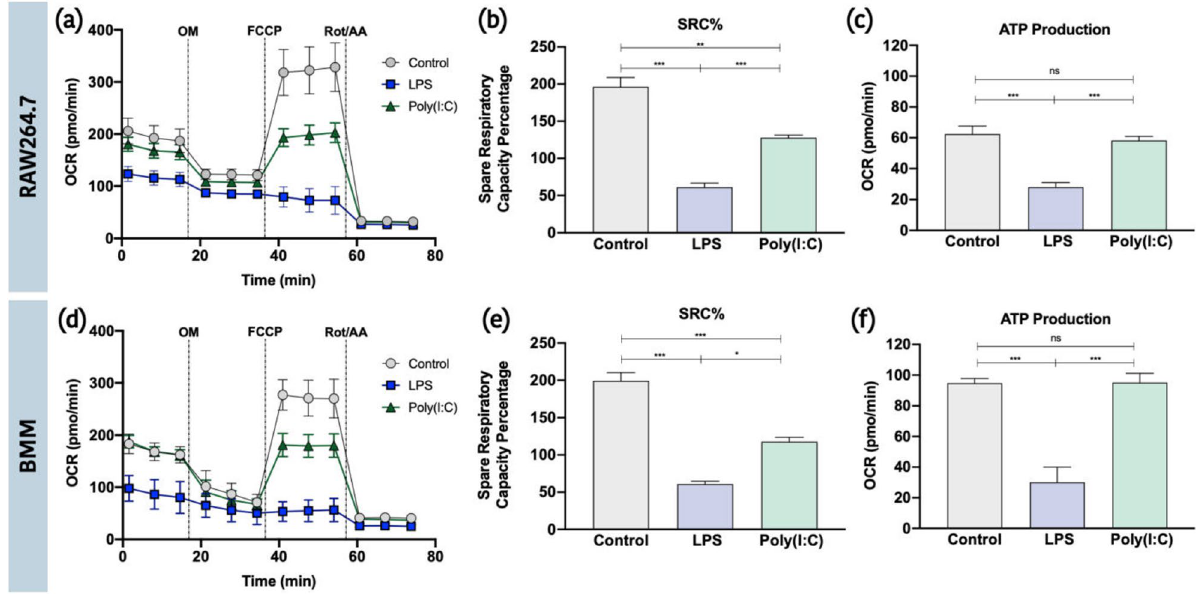
Figure 1. Primary macrophages are more dependent on mitochondrial-derived ATP than macrophages originating from cell lines. RAW264.7 cells ( a – c ) and primary mouse BMM ( d – f ) were seeded onto Seahorse XFp miniplates and were treated with 100 ng/mL LPS or 10 ng/mL Poly(I:C) for 18 h. Mitochondrial function was measured following sequential injections of Oligomycin (OM), Carbonyl cyanide-p- trifluoromethoxyphenylhydrazone (FCCP), and rotenone plus antimycin A (Rot/AA), resulting in the calculation of the spare respiratory capacity percentage (SRC%) and ATP production. Data represents mean ± SEM of three individual mice (BMM) or experiments (RAW) (*p < 0.05, **p < 0.01, and ***p <